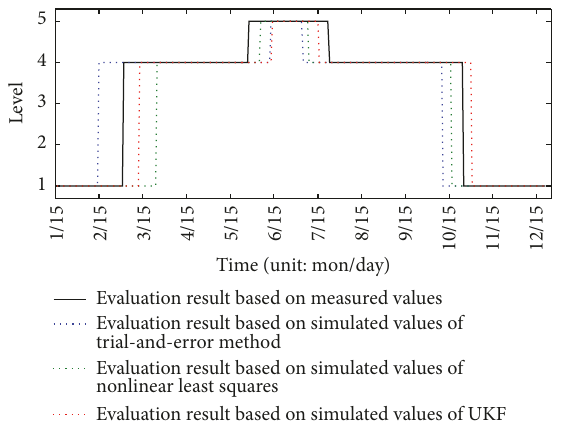
Figure 5: Evaluation result of the monitoring station.